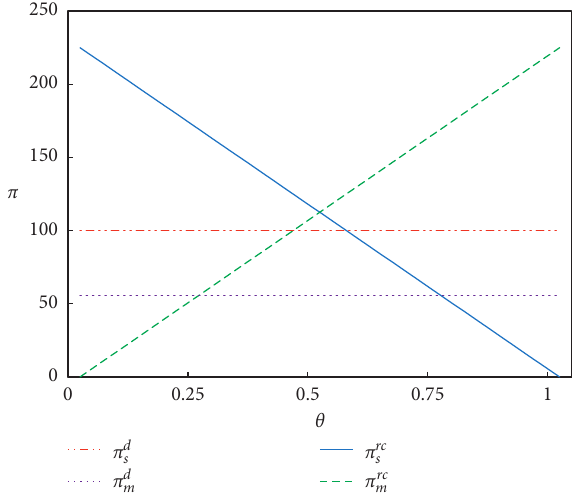
Figure 9: The revenue-sharing coefficient’s impact on the profits of core enterprises and